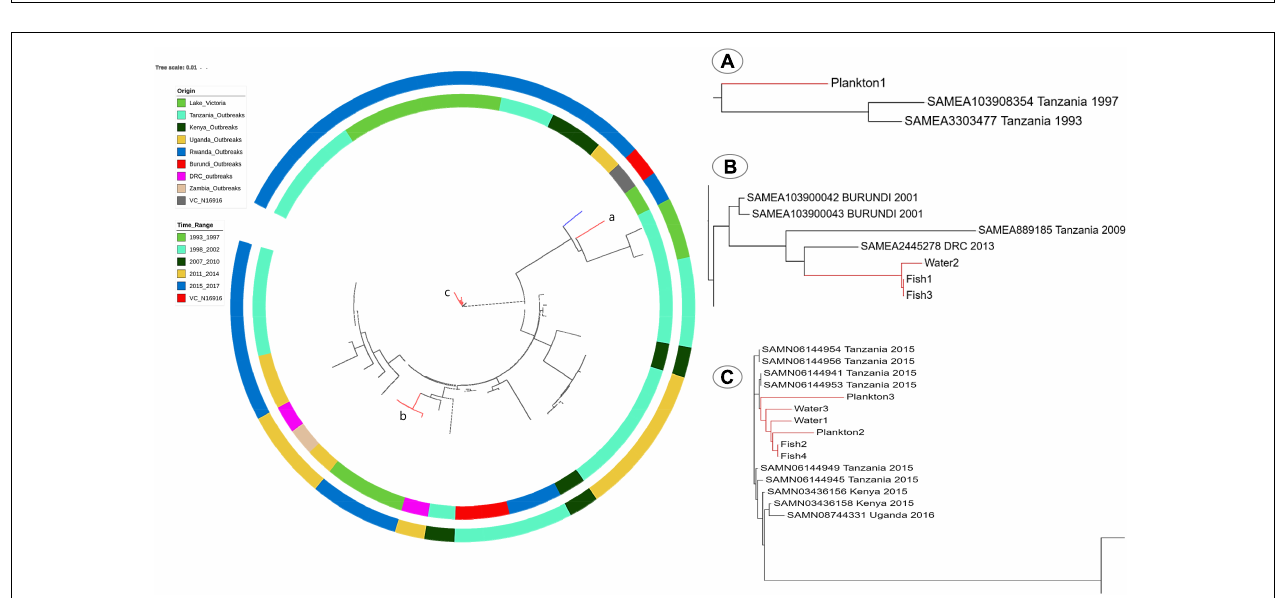
FIGURE 4 | Selected genetic elements encoding for environmental fitness. Strain Plankton2 was used for this illustration. The contig in which the genetic complex are found is indicated.